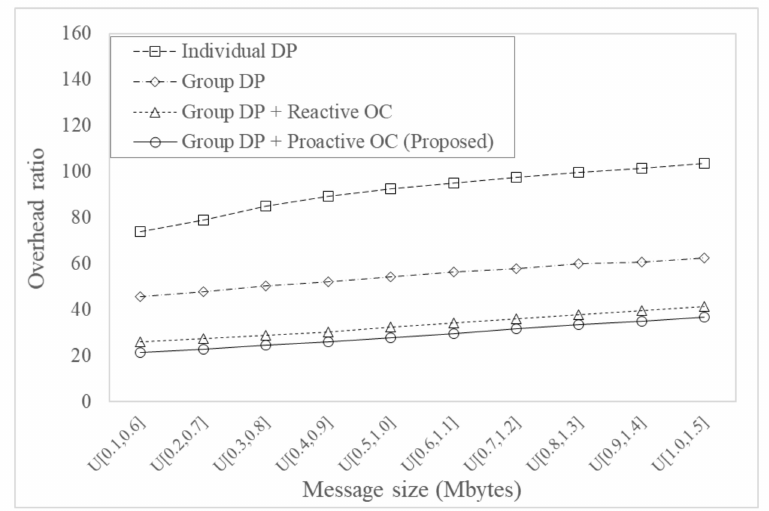
Figure 9. Overhead ratio for varying message size.